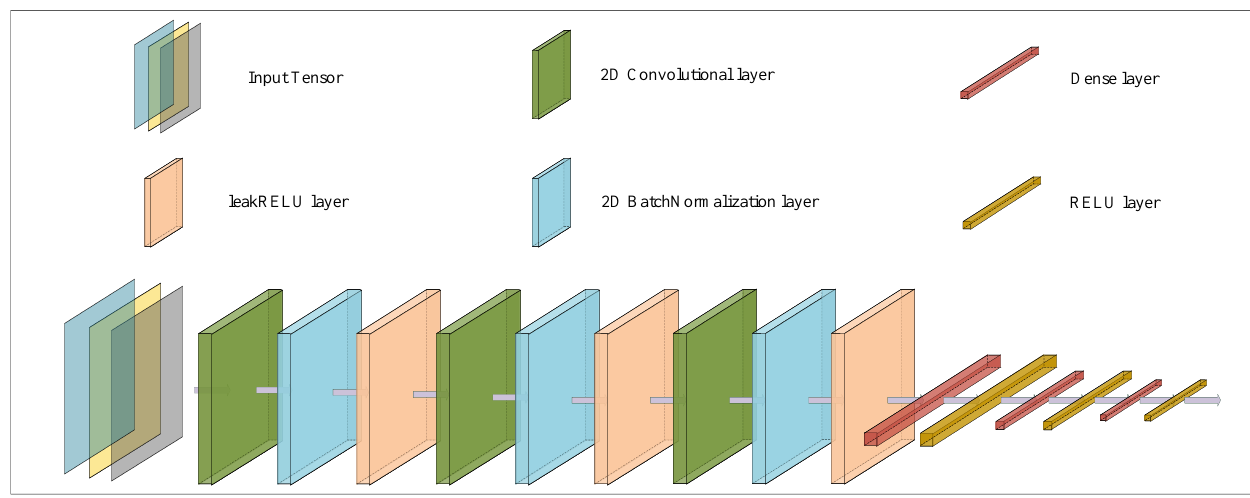
Figure 4. Structure of the first-stage rough DOA estimation